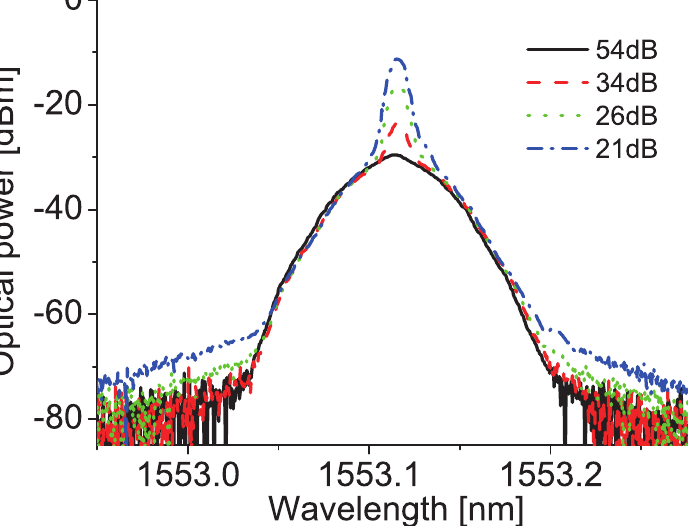
Figure 12. Optical spectra of duobinary signals with various ERs